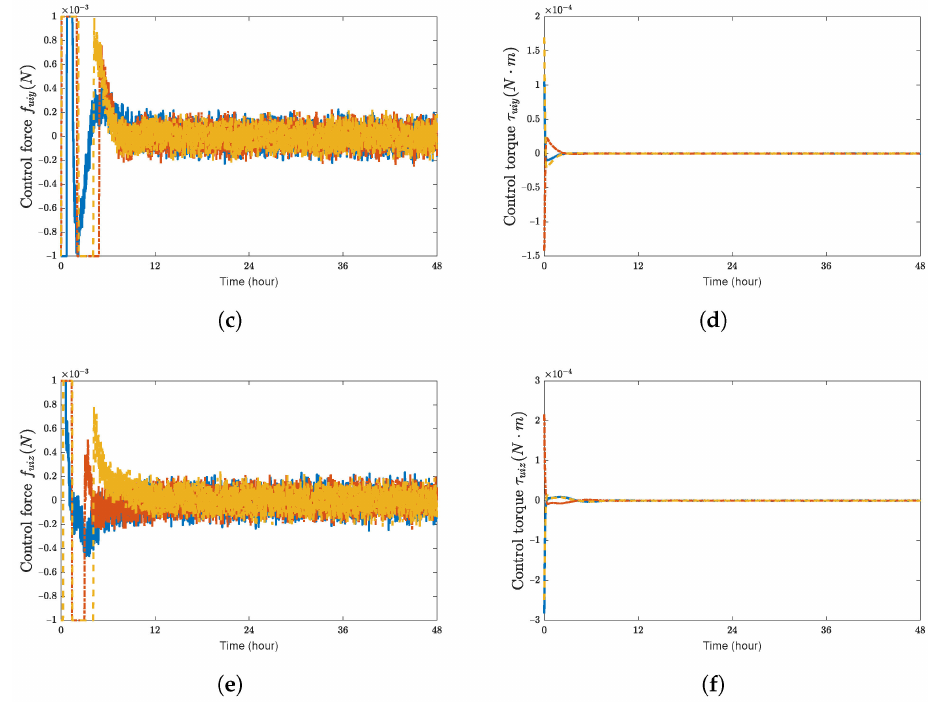
Figure 6. Control forces and control torques of spacecraft SC1 ∼ 3 with adaptive control law.